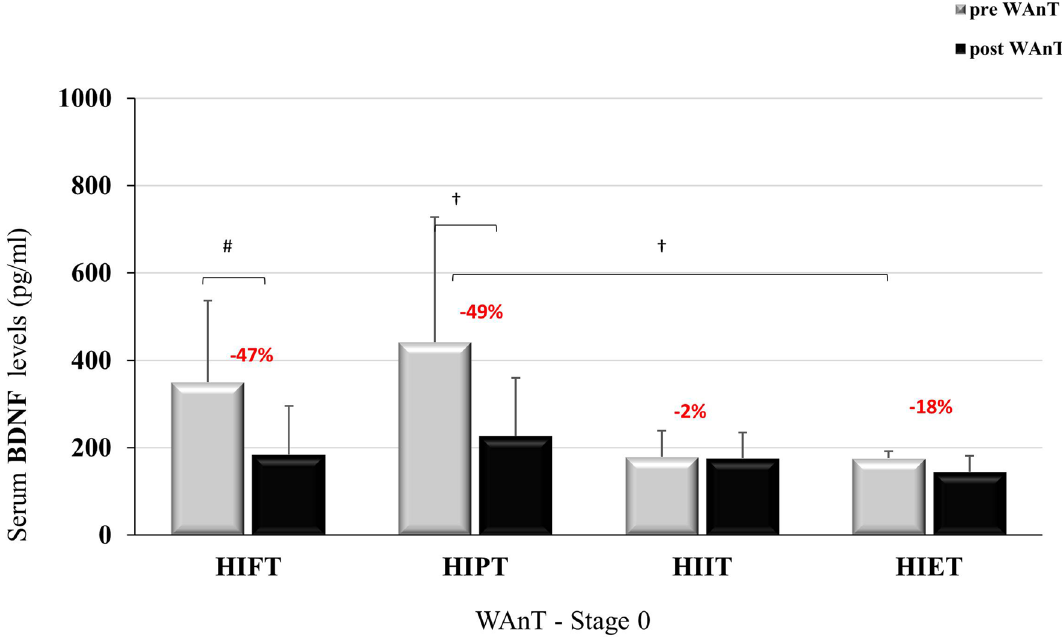
Figure 3. BDNF level at stage 0, -pre and post-WAnT; *p < 0.05; # p < 0.01; † p < 0.001.